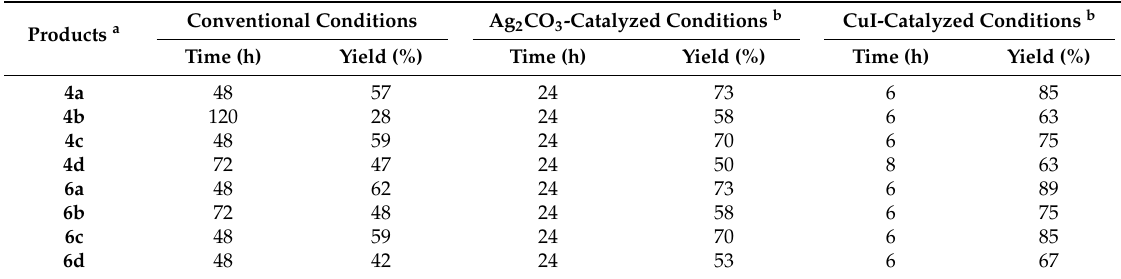
Table 1. Formation of isoxazoles 4a – d and triazoles 6a – d under conventional and catalytic conditions. Products